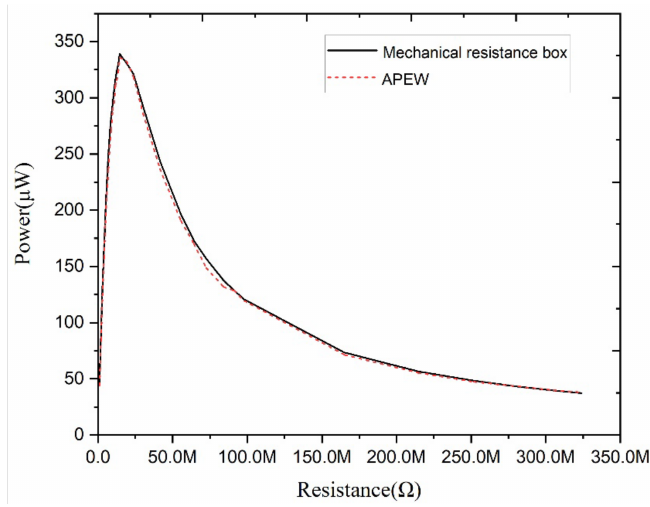
Figure 8. The test results of the TENG output